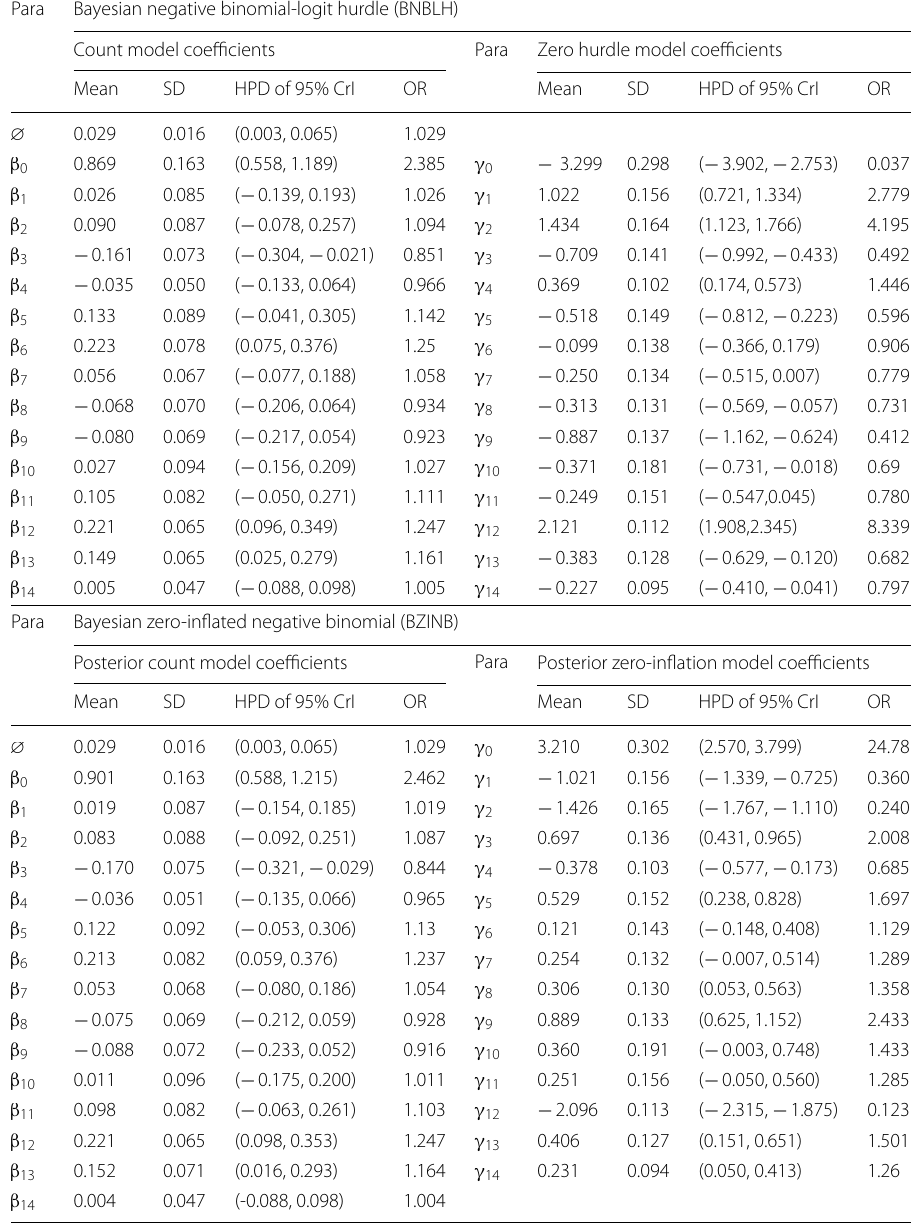
Table 4 Summary statistic of the posterior distribution of the model